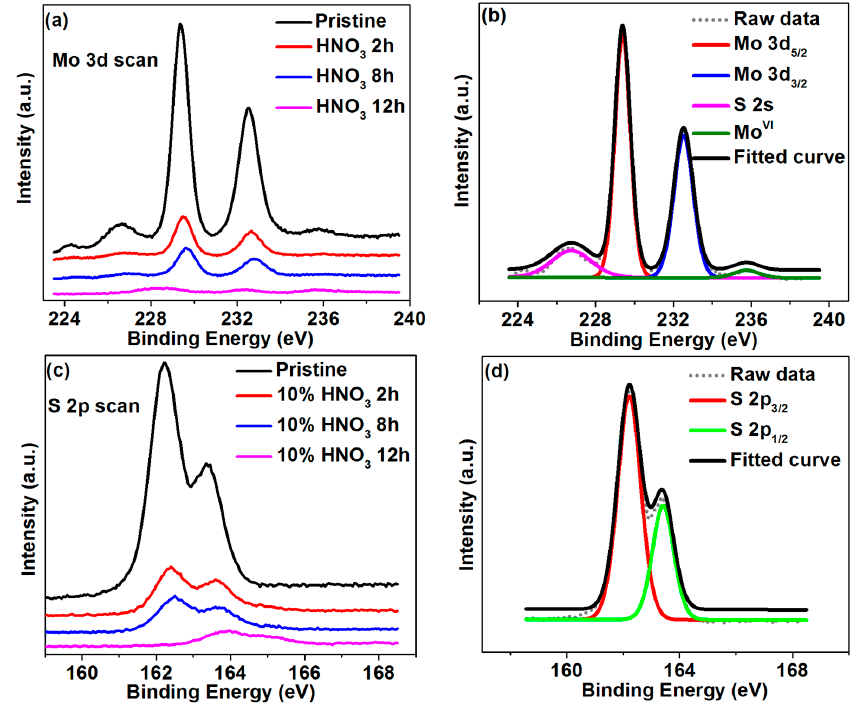
Figure 4. XPS results of different samples: ( a , c ) Mo 3d and S 2p curve comparison among different durations of acid-treated (pristine, 2 h, 8 h, 12 h) MoS 2 @CNT, and ( b , d ) pristine MoS 2 @CNT Mo 3d and S 2p deconvolution.